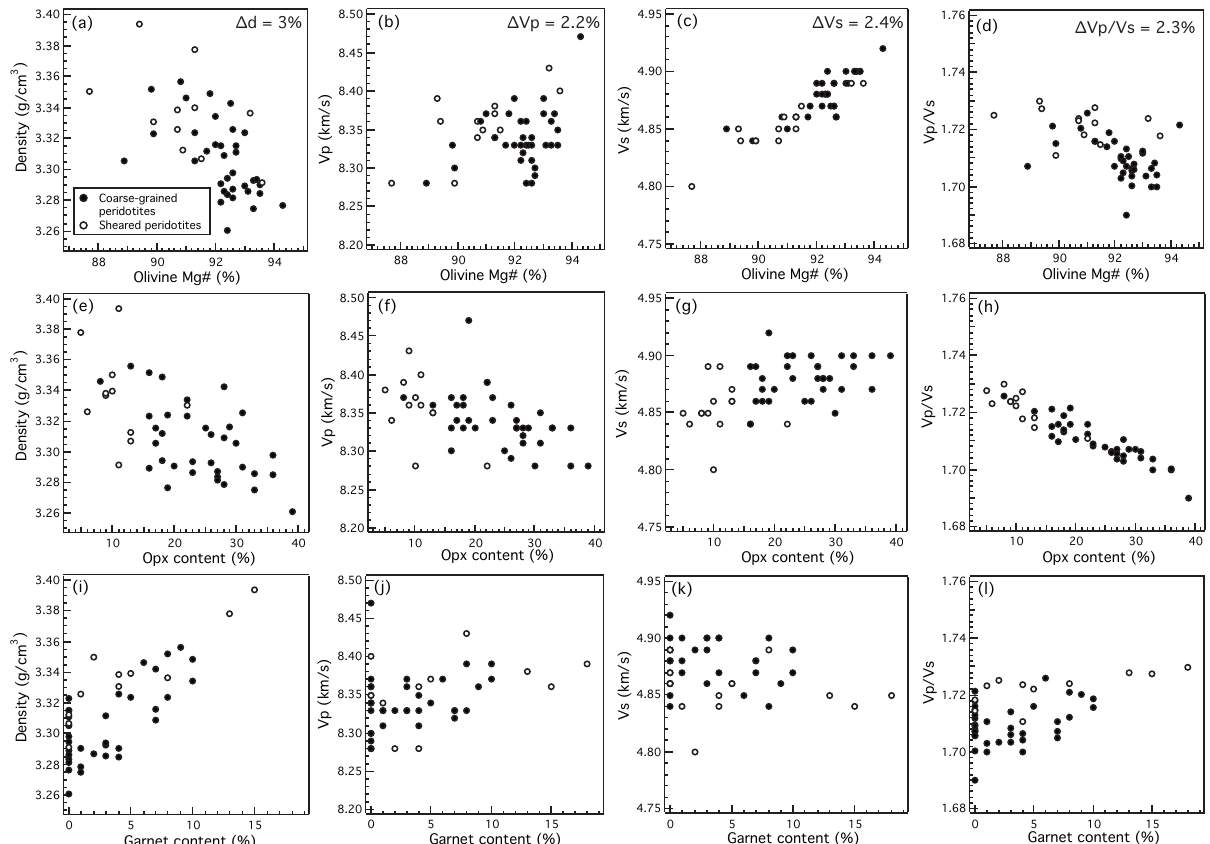
Fig. 4. Evolution of the samples’ densities, P wave velocities ( V p ), S wave velocities ( V s ), and V p /V s ratios with olivine Mg#, orthopyroxene (opx) content, and garnet